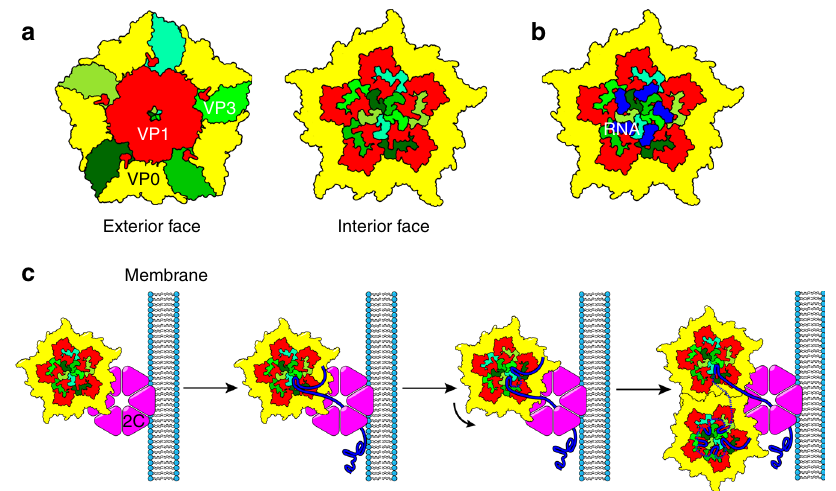
Fig. 6 Cartoon of a plausible virion assembly mechanism. The crystal structure (PDB: 4Z92) 4 was used to create a simpli fi ed cartoon of the pentameric capsomere. a left , shows a view along the fi ve-fold axis into the virion, i.e. the outer surface. The CP subunits are coloured, yellow for VP0; red for VP1 and various shades of green for the different VP3 subunits. The right hand panel shows the view along the same axis from the centre of the virus, highlighting the extension of the N-terminal arms of the VP3s around the symmetry axis. b shows a similar view with the ordered RNA segments in dark blue . c A cartoon of a hypothesised model of capsid assembly based on known aspects of picornavirus morphogenesis 2 . Pentamers of the viral CPs are bound by the 2C ATPase , associated with a replication factory at the cell membrane via sequence-speci fi c protein-protein contacts to VP1 or VP3. Here they contact newly replicated genomic RNA. The 2C ATPase is known to play multiple roles in virion replication and morphogenesis. Its RNA helicase activity would allow it to bias RNA folding to short-range contacts, favouring the appearance of the PSs in HPeV1. These could then associate with their binding sites on a pentamer. As each protomer binds RNA, the genome would form a loop until the next PS sequence appeared. This could attach to a neighbouring binding site by chance, or pentamers could rotate relative to 2C to orientate the RNA at unbound sites. Once a pentamer ’ s RNA sites are full, a second pentamer may become associated forming the CP-CP contacts seen in the virion. Such a model accounts both for the data described here and previous models of picornavirus HPeV1 compared to GMK. The HT29 and GMK cells were tested for mycoplasma prior to use. RNA replication of the mutants . In order to gauge the ef fi ciency of viral RNA and protein production in the GMK cells, the transfected cells were produced as for the above end point assay. In addition, cells were infected with HPeV1 virions (MOI 0.1) to serve as a positive control, and untransfected cells were used as a negative control. In order to detect the formation of double-stranded viral RNA, an immuno fl uorescence assay was performed. The cells were fi xed at 6h post second transfection with 4% paraformaldehyde for 15min at room temperature (RT). The cells were washed twice with 1× PBS and permeabilised with 0.1% Triton X-100 for 20 min at RT, followed by blocking (3% bovine serum albumin and 0.1% Tween-20 in 1× PBS) at RT for 1 h. The primary antibody incubation was done at 4°C overnight with mouse J2 mAb against dsRNA (English and Scienti fi c Consulting Kft., Cat# 10010200; stock: 1 mg/ml) at a 1:1500 dilution. The cells were washed pHPeV1 (kind gift of Petri Susi, University of Turku), using the Geneart three times with 1× PBS and incubated with a fl uorescein isothiocyanate (FITC) site-directed mutagenesis system (Invitrogen) according to the manufacturer ’ s labelled anti-mouse secondary antibody (Sigma) at 1:200 dilution. The cells were instructions 31 . The primers are listed in Supplementary Table 4. washed three times with 1× PBS. The 4 ′ ,6-diamidino-2-phenylindole (DAPI) stain Infectious genomic RNA was produced after transfection and translation in (Sigma) at a working concentration of 0.1µg/ml was added to the cells. The images GMK cells. For this, the plasmids containing the cDNA clones of mutants were obtained with a Floid Cell Imaging Station (Life Technologies) in the or wild-type, were used as the templates to produce linear cDNA by PCR Biocenter Finland Light Microscopy Unit, University of Helsinki. ampli fi cation using the T7 promoter-containing forward primer, On the 2nd day post the second transfection, the wild type, mutants, positive 5 ′ -TAATACGACTCACTATAGGGTTTGAAAGGGGTCTCCTAGAGAG-3 ′ and virus infection and negative controls from the GMK cells were used for both total polyT-containing reverse primer 5 ′ -TTTTTTTTTTTGTCATGTCCAATGT RNA extraction with Trizol (Invitrogen) and the production of cell lysates by TCC-3 ′ . The PCR running conditions were 98 °C (5 min), [98 °C (30 s) +55 °C freeze-thawing. (30 s)+ 72 °C (5 min)]× 25, 72 °C (10 min), 4 °C. The resulting linear cDNA The total RNA was used for cDNA synthesis with random hexamers utilising a contained the T7 promoter and the appropriate full-length HPeV1 cDNA genome. Phusion RT kit (Thermo Scienti fi c). The cDNA was subjected to quantitative real- time PCR (Roche) using primers and a probe designed for a 142bp-long conserved 5 ′ UTR region as described earlier 34 . Susi) using Lipofectamine 2000 (Life Technologies, Cat# 11668027). Next day, these GMK cells were transfected with the linear cDNA, to generate full-length In vitro translation of the mutants . Plasmids carrying the wild type genome genomic RNA, which in the control experiments with the wild type cDNA, (pHPeV1) or its mutants were transcribed and translated using the TNT Quick generates virions. Cell lysate was prepared from the transfected cells on the 3rd day Couple Transcription/Translation system (Promega) as per the manufacturer ’ s post the second transfection by two cycles of freeze-thawing at − 180°C and 37°C. protocol. A plasmid carrying the luciferase gene (provided in the kit) was used as The cell lysate was treated with RNase I (ThermoFisher Scienti fi c, Cat# EN0601) the positive control. The proteins were labelled with 35 S-methionine. The signal and DNase I (ThermoFisher Scienti fi c, Cat# EN0525) for 30 min at 37 °C to was obtained on a phosphoimager after overnight exposure. degrade any residual free RNA or DNA and subsequently added to HT29 cells (human colorectal adenocarcinoma cell line; Sigma, Cat# 91072201-1VL) and Microscale thermophoresis (MST) . We generated 5 ′ -Alexa-488-labelled RNA scored for CPE for 4 days. The viral titres were expressed as 50% tissue culture infectious dose (TCID50) per ml using an end-point titration method described oligomers based on the genome sequences for the PSs (PS6, PS7, PS9, PS14 and earlier 33 . The HT29 cells are an indicator cell line which shows clear CPE for PS21) and their sequence variants and measured their af fi nities for HPeV1